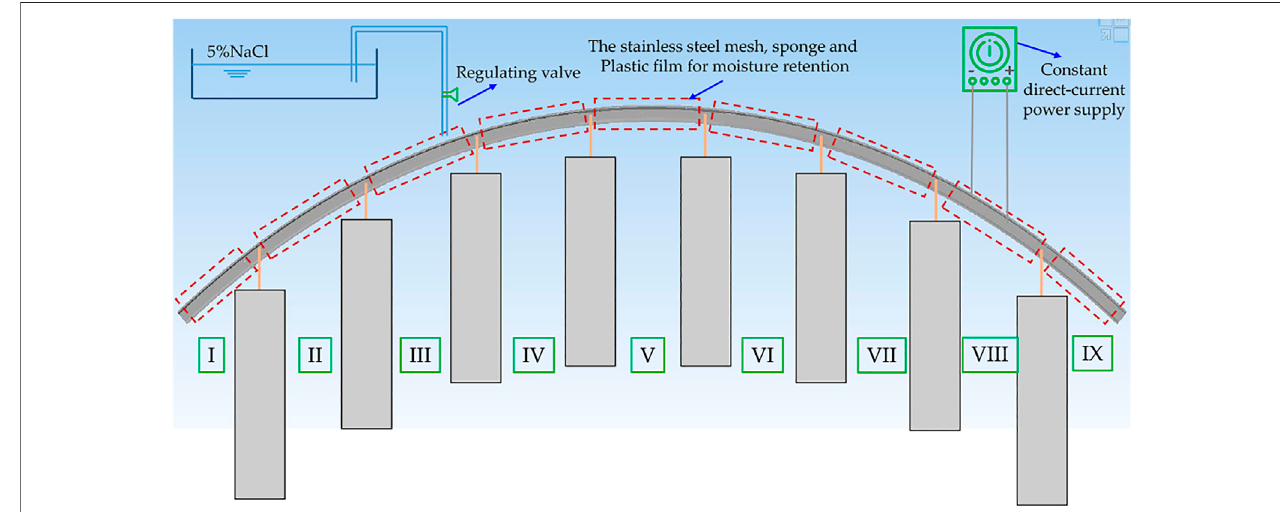
FIGURE 4 | Corrosion diagram of the arch model.